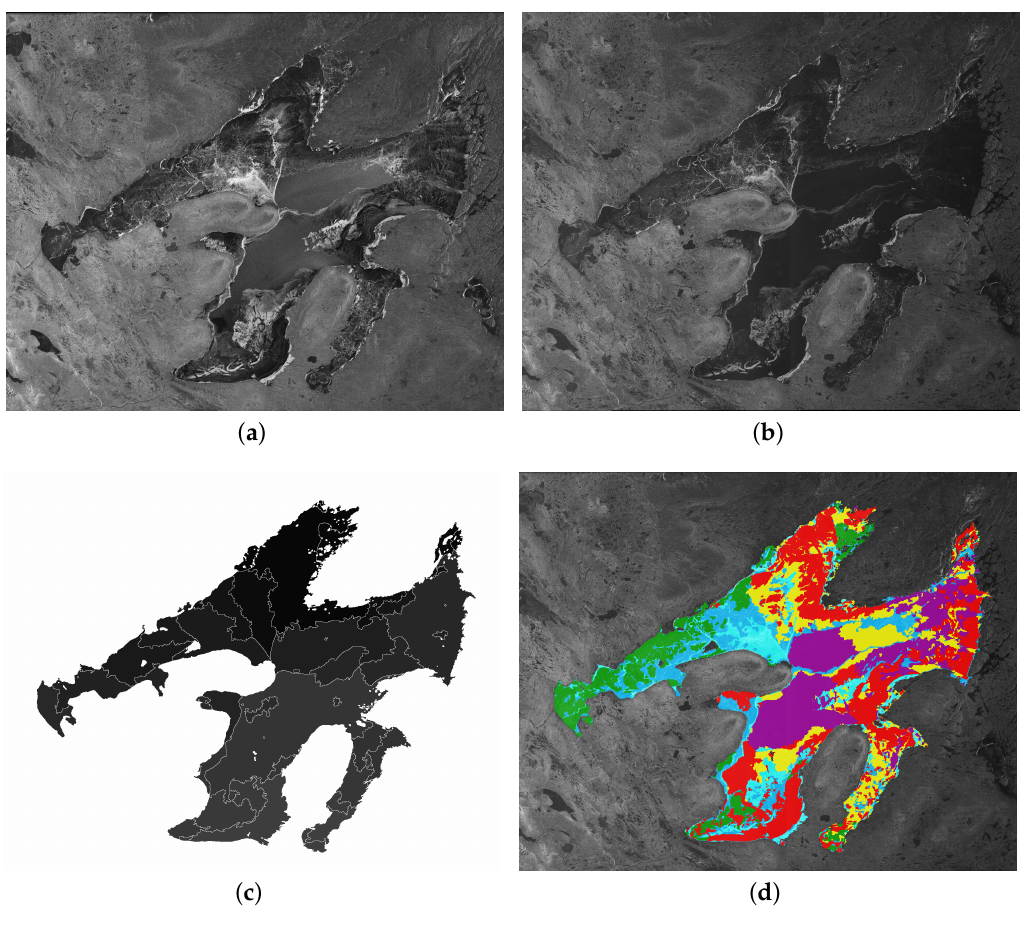
Figure 2. Steps of the IRGS segmentation approach for the scene from 2 December 2015. ( a ) HH polarization SAR image, ( b ) HV polarization SAR scene with brightness increased by 75%, ( c ) Autopolygons; HV image after autopolygon segmentation, ( d ) Segmentation; all segments ‘glued’ into the final chosen number of